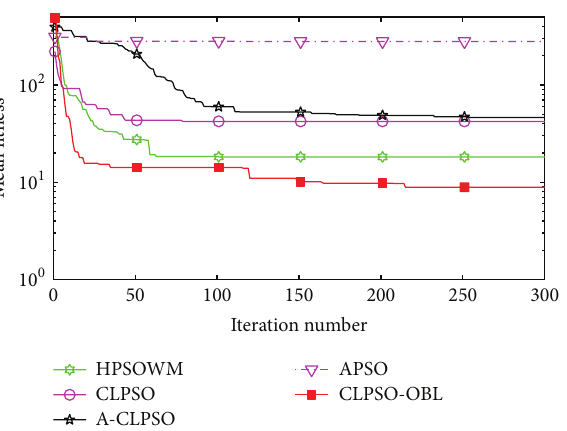
Figure 4: The convergence curve of five PSOs on PMSM parameter estimation under normal temperature condition.